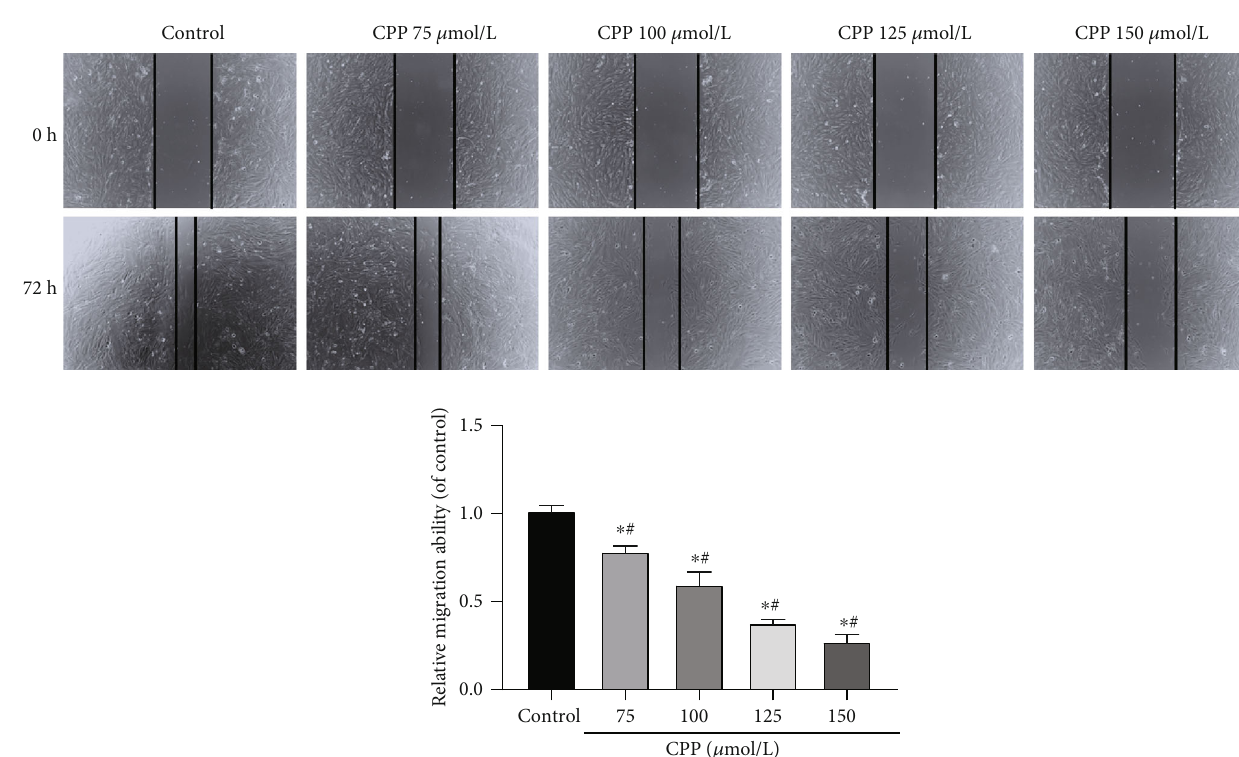
Figure 5: CPP treatment reduces U251 cell migration capacity. Compared with the control group, ∗ indicates p < 0 : 05 . Comparison between treatment groups with di ff erent concentrations of CPP (75, 100, 125, and 150 μ mol/L), # indicates p < 0 : 05 . This experiment was repeated three times independently.